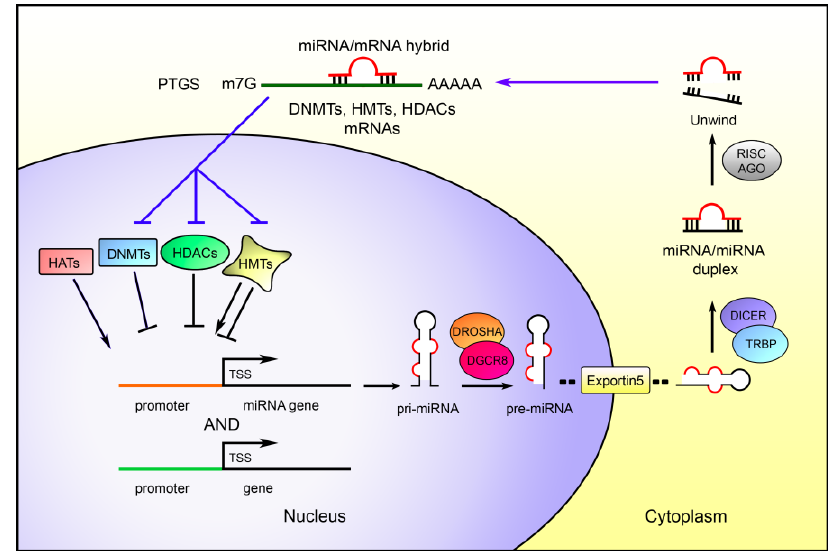
Figure 1. Feedback circuit between microRNAs and epigenetic machinery . The epigenetic modification, such as promoter CpG island hyper- or hypo-methylation and/or histone modifications, affect miRNAs and genes transcription. MiRNAs can themselves regulate the epigenetic machinery by post-transcriptional gene silencing (PTGS), targeting DNMTs, HDACs, and the histone methyl-transferases (HMTs), establishing epigenetic pathway loops. In the figure, black lines represent the pathway starting from the epigenetic modifications and ending with the miRNAs maturation, while blue lines represent the pathway from the mature miRNA to the post transcriptional gene silencing of the epigenetic machinery.